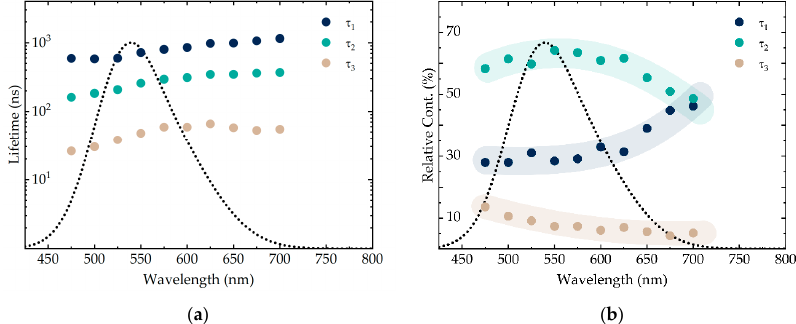
Figure 4. The PL decay components τ 1 , τ 2 and τ 3 ( a ) and their relative contributions ( b ) acquired calculated from the decay curves of the free AIS/ZAIS/ZnS quantum dots. The semi-transparent colored lines in ( b ) indicate the trend.